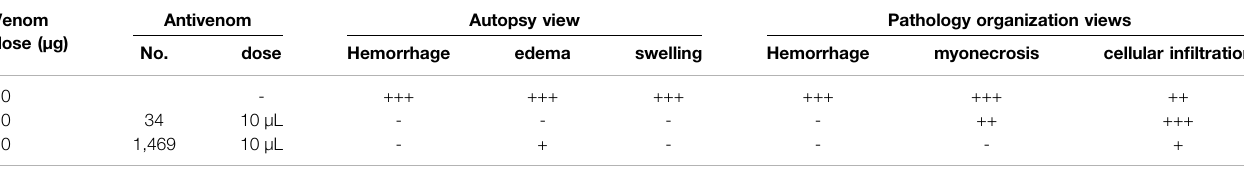
TABLE 1 | Anti-pathological suppressing effect of antivenoms. Venom dose ( μ